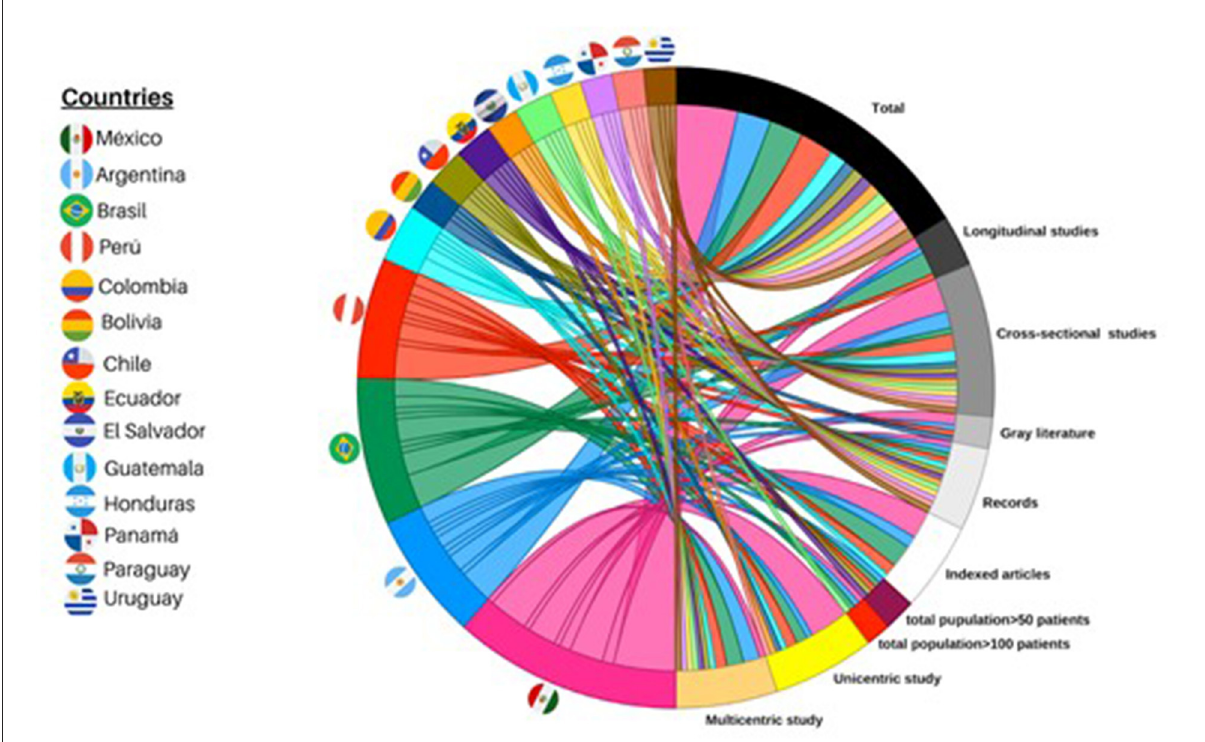
FIGURE2 Chordal graph, information characteristics. A chord diagram is constructed from the information. Half circle shows each country with a specific color (for example, Mexico is pink); Each string is directed to a tape representing a variable (for example, longitudinal studies). The thicker the string, the greater the number of studies it